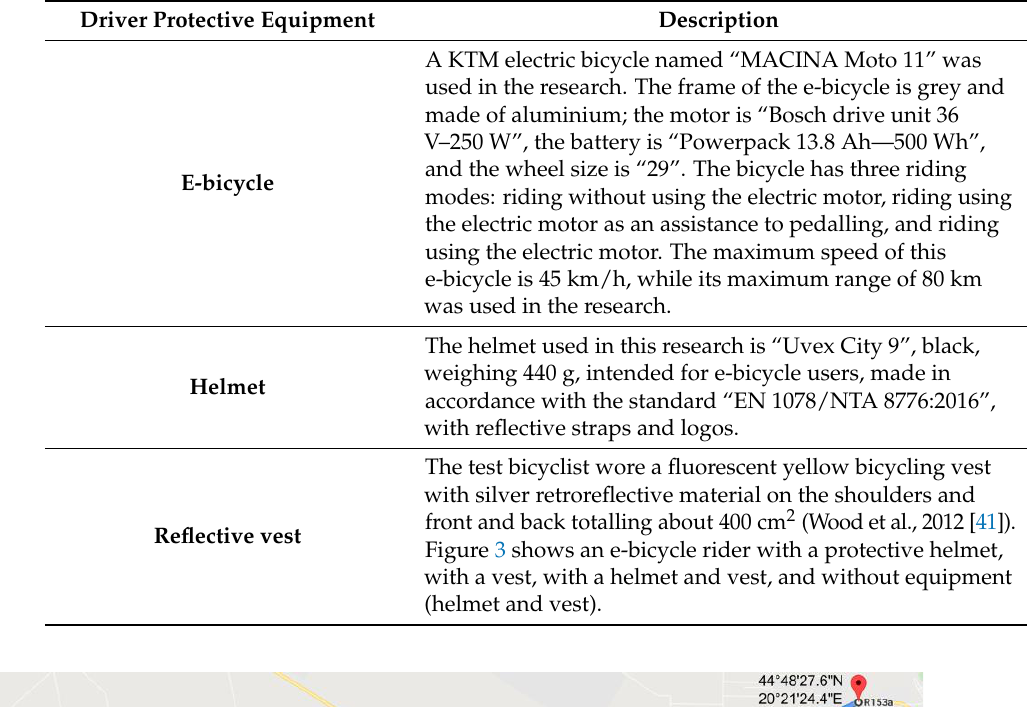
Table 1. Description of the characteristics of the driver protective equipment.